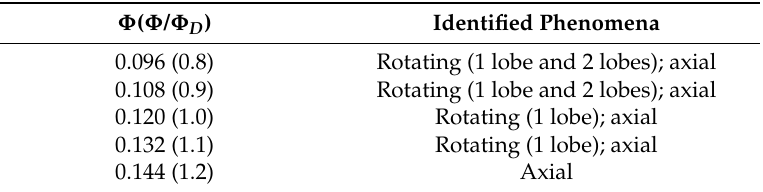
Table 7. Identified phenomena at different flowrates.